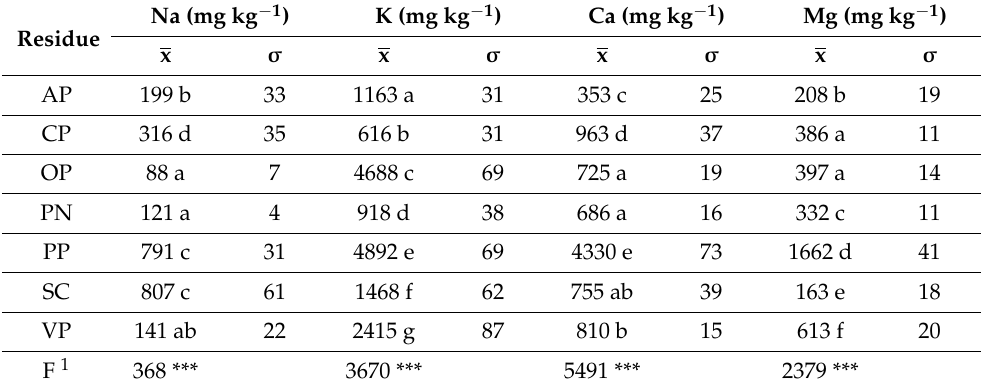
Table 5. Water extract macronutrients average content (x) and standard deviation ( σ ) of each residue. Residue